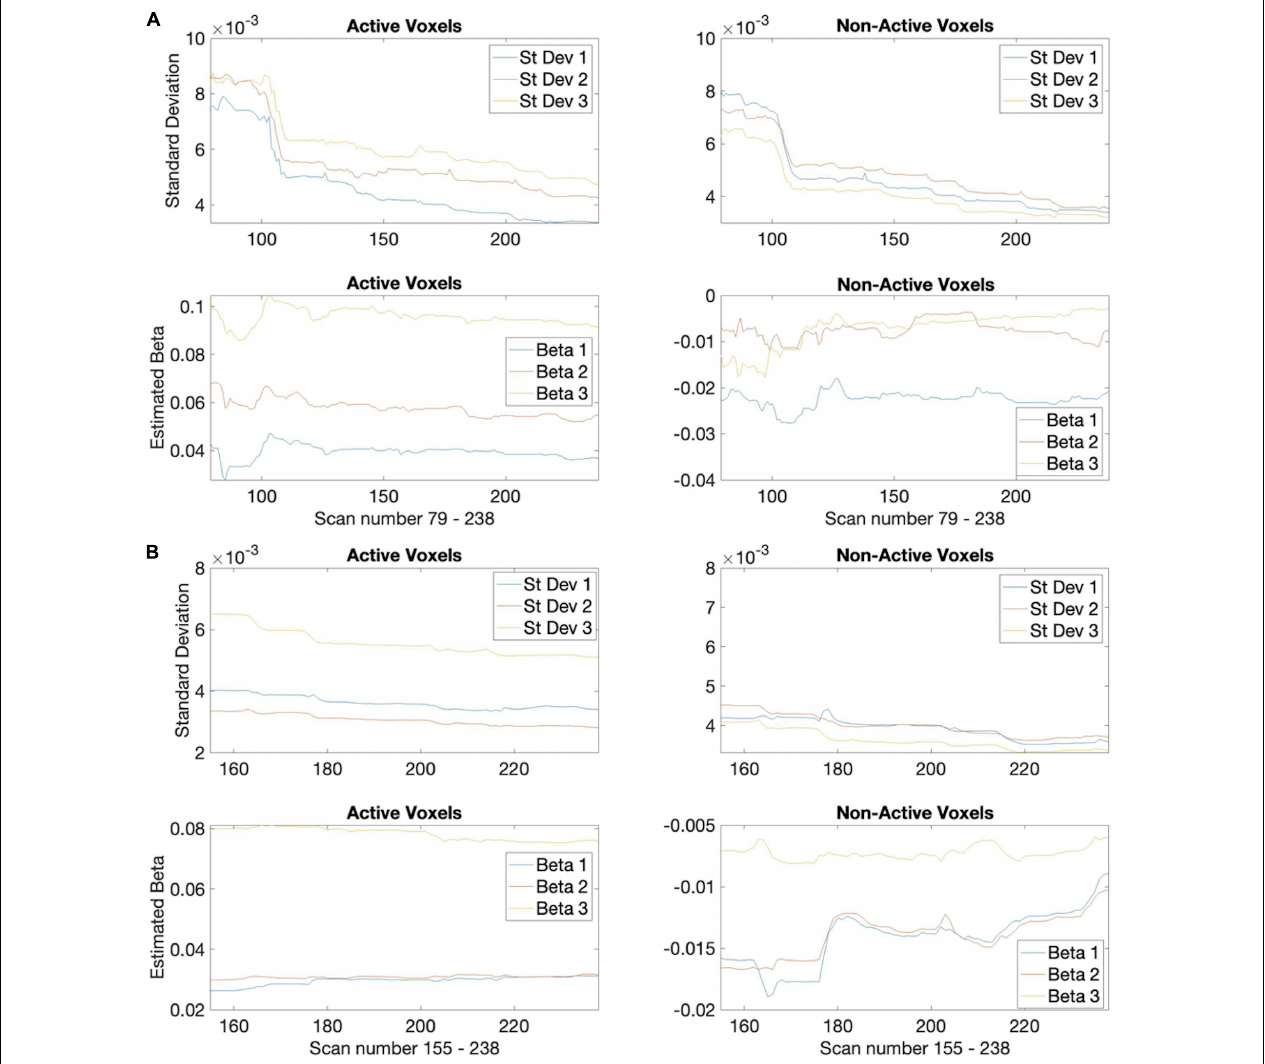
FIGURE 4 | Estimated standard deviations for the easy task parameter. Plots for 3 example active (left) and non-active (right) voxels from a control subject (subject 3) showing how the estimates decrease over time (scan number). (A) Based on 2-block first stage estimation, (B) 4-block first stage